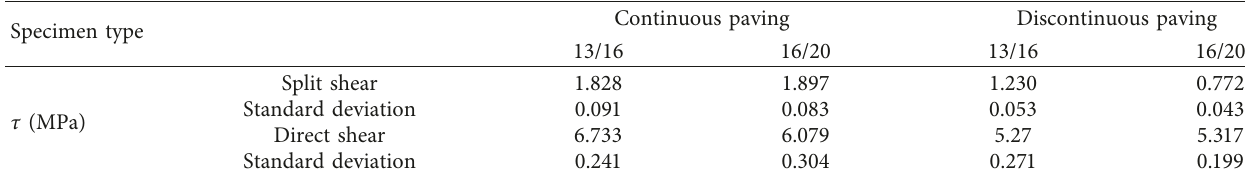
Table 8: Results of shear test at low temperature.